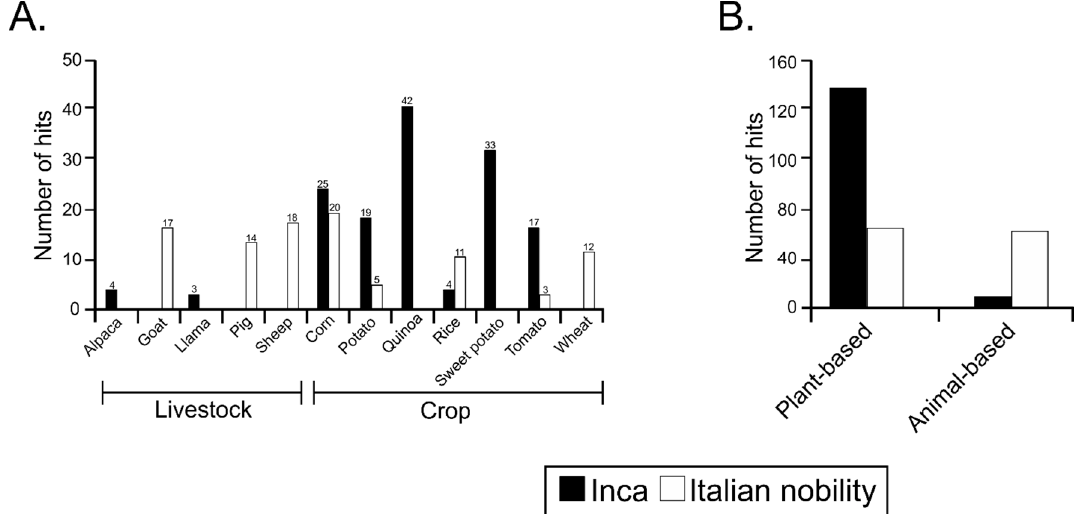
Figure 2. Relative proportions of plant and animal sequences identified in the guts of pre-Inca/Inca and Italian nobility mummies. ( A ) Number of sequence hits associated with livestock including alpaca, goat, llama, pig and sheep, and crops including corn, potato, quinoa, rice, sweet potato, tomato and wheat; ( B ) Sequence hits were then classified as plant- or animal-based diets. Contigs were uploaded to DiaGrid BLASTer tool (https://diagrid.org/tags/blasterupload) and annotated using a minimum identity of 80% and e-value of 10 × 10 − 5 . Plant and animal sequences were then manually curated to their common